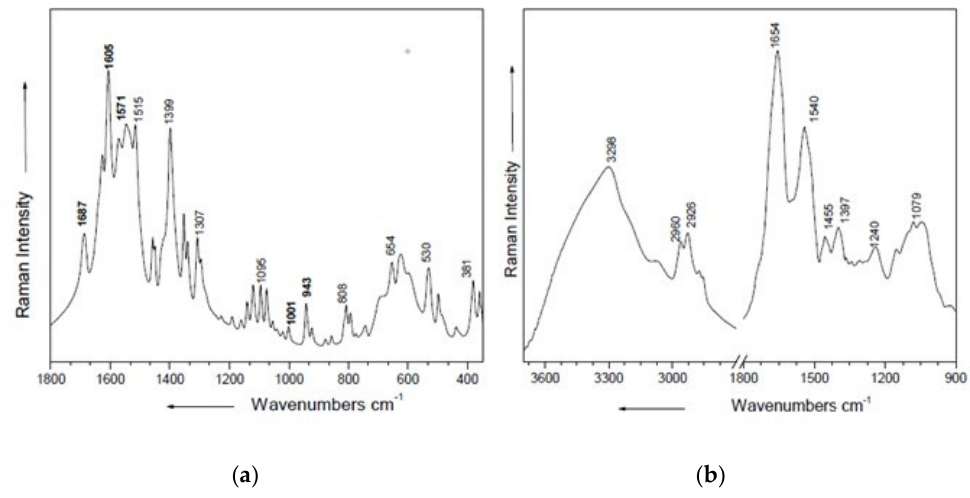
Figure 4. The FTIR spectrum of MSG ( a ) and spirulina powder ( b ).